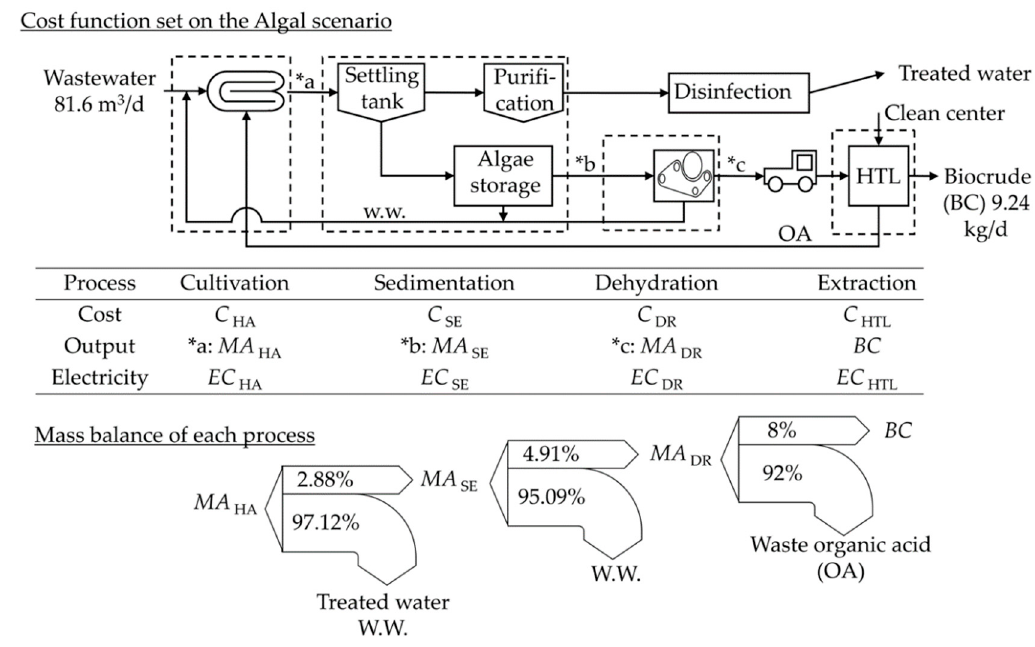
Figure 8. The cost function and mass balance for each process, based on the flow of the algal scenario (Figure 6).